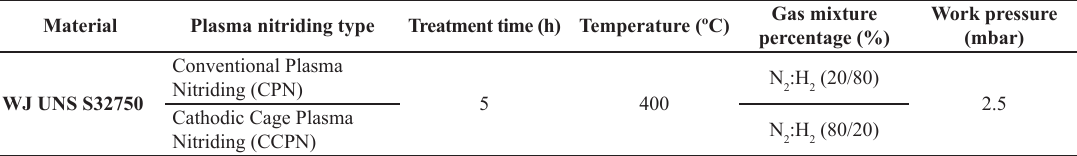
Table 3. Nitriding parameters.